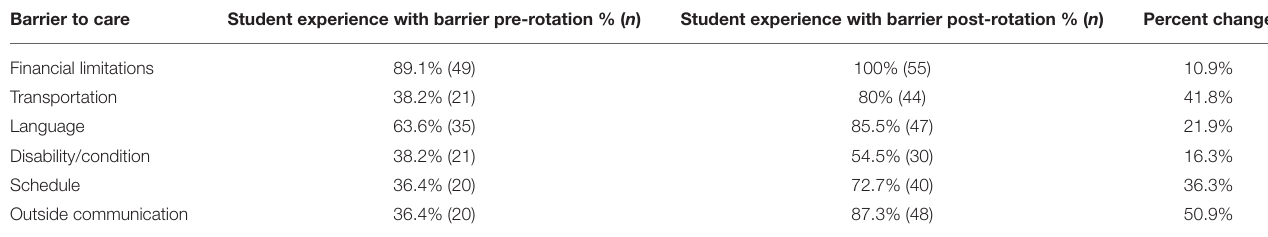
TABLE 1 | Percentage of students with experience managing barriers to care before and after participating in a service-learning community medicine rotation. Barrier to